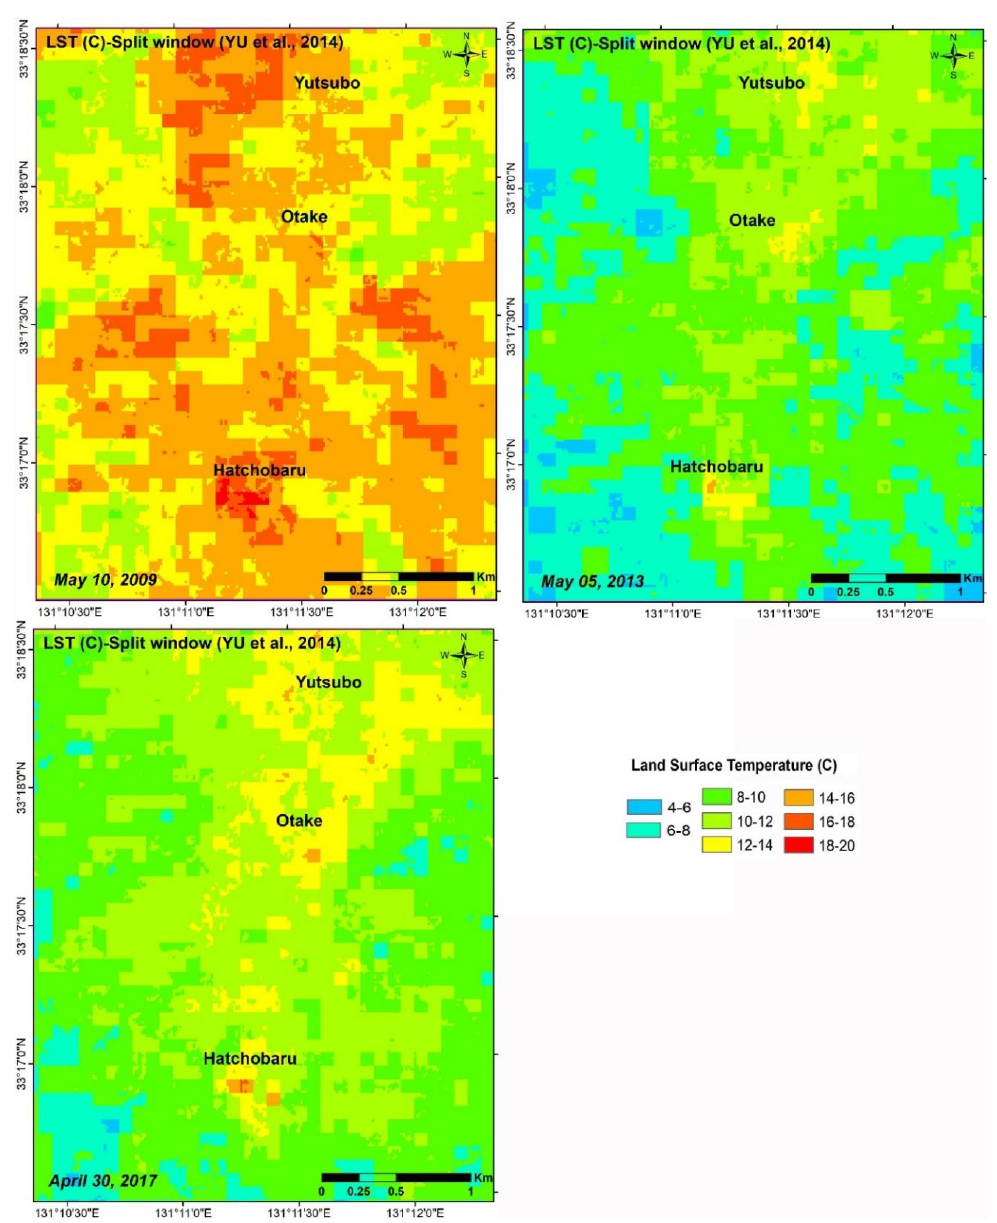
Figure 5. Land surface temperatures (LSTs) for the study area for 2009, 2013, and 2017, derived from nighttime ASTER thermal infrared data, using the split-window method from the literature [19].